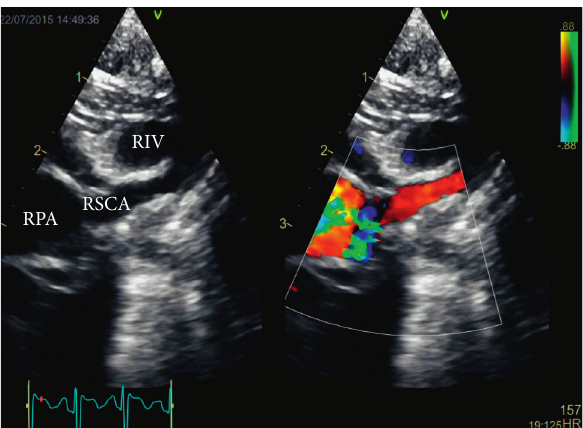
Figure 2: Echocardiography of the newborn with B-image on the left and a simultaneous color Doppler on the right; in a high right parasternal long axis, an aberrant origin of the right subclavian artery (RSCA) from the right pulmonary artery (RPA) could be displayed with course towards the right arm. RIV, right innominate artery.